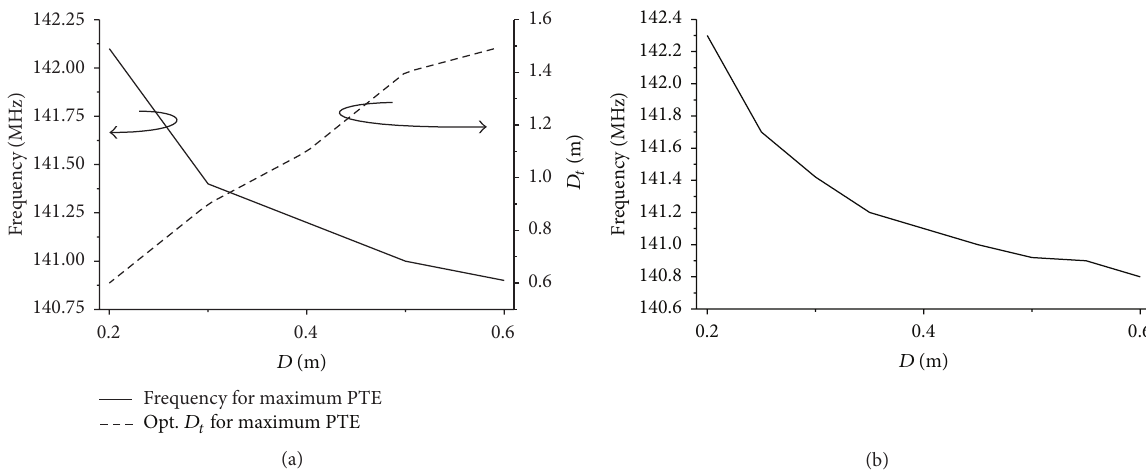
Figure 8: Optimum conditions for maximum efficiency PTE mat against separation 𝐷 (a) retriever-based system and (b) the classical WPT system.